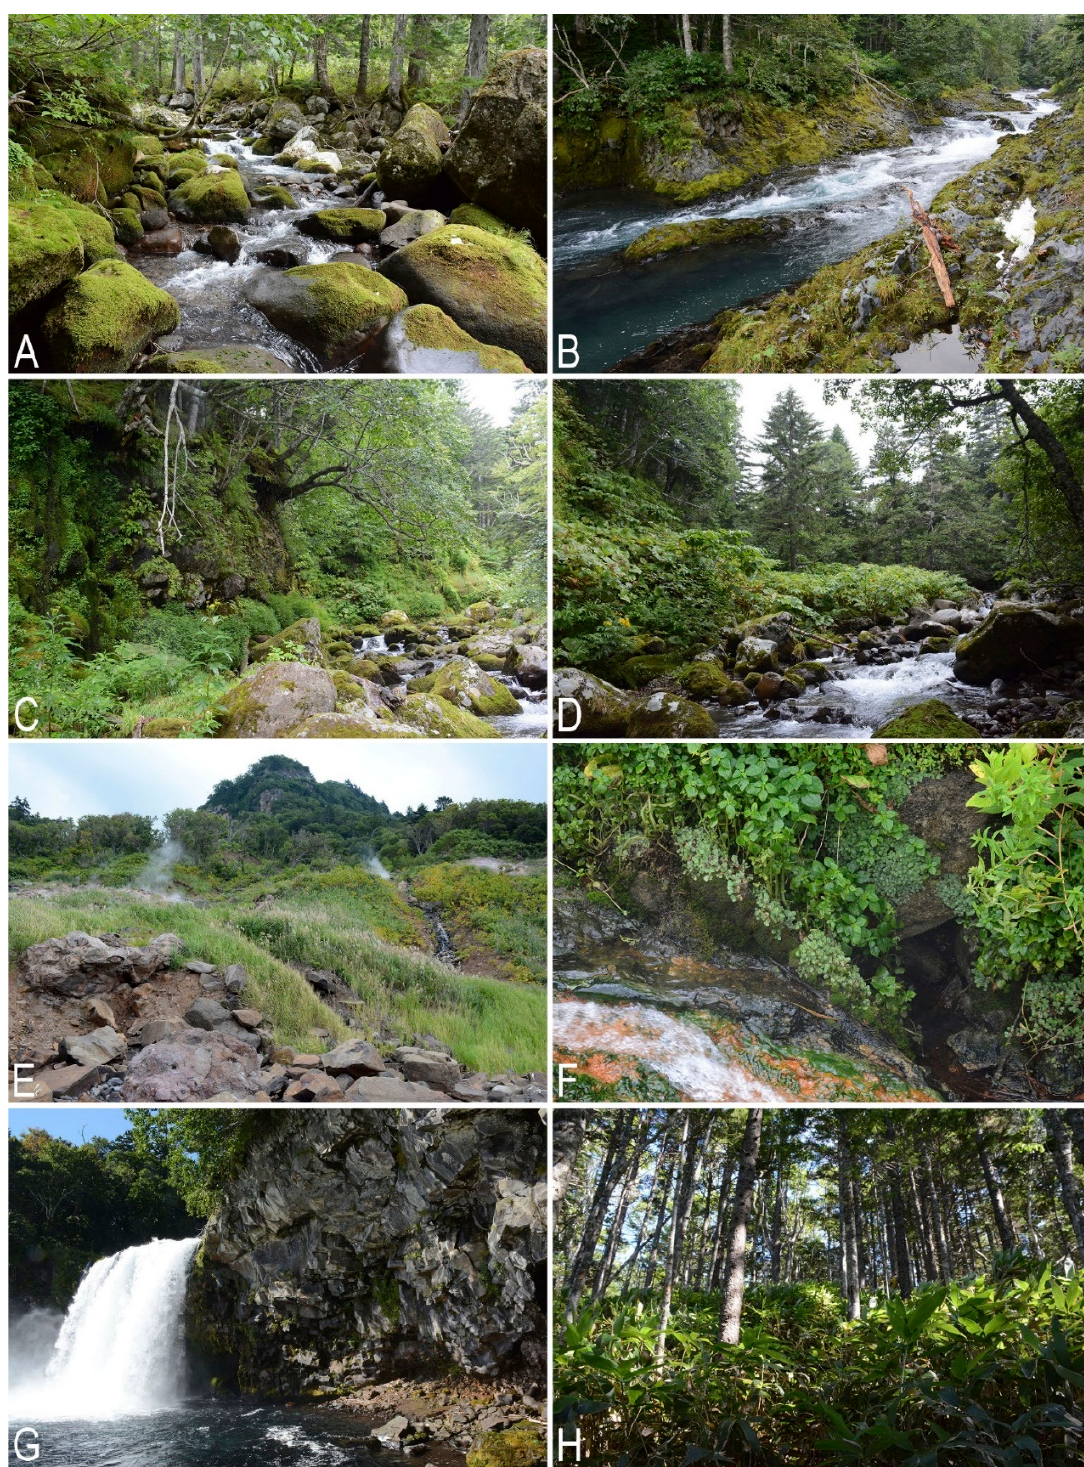
Figure 5. Liverwort habitats on Kunashir Island: ( A , C , D ) Gornaya River valley, northern part of the island, stream valeys in lower altitudinal belt; ( B ) Ptichiya River valley, northern part of the island, river valley; ( E ) coastal slope, Neskuchenskiye Hot Springs area, northern part of the island; ( F ) Marchantia paleacea along thermal stream, surrondings of Dal’ny Stream mouth, northern part of the island; ( G ) Ptichiya River mouth, northern part of the island; ( H ) Abies nephrolepis (Trautv. ex Maxim.) Maxim. forest with Sasa understory, middle part of the island (Photo by K.G. Klimova, 2018).